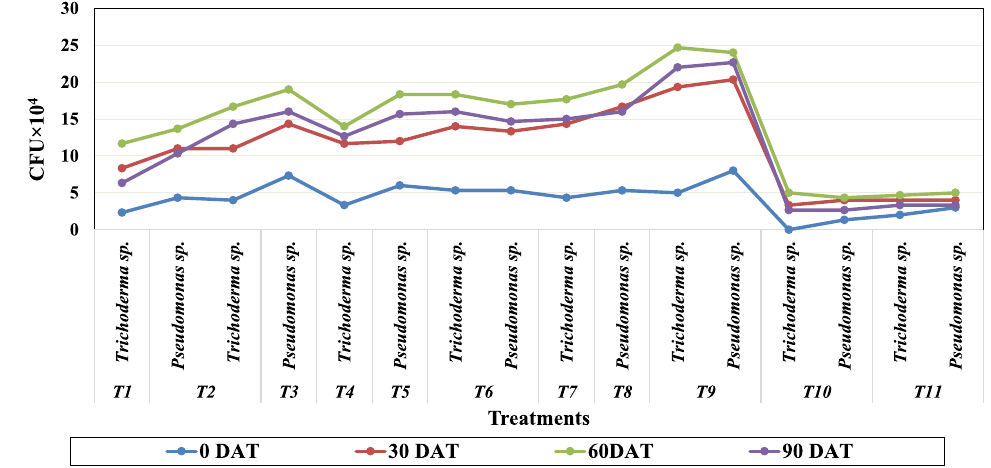
Fig. 4 Rhizoplane Population of Trichoderma spp. and Pseudomonas fluorescens in different combinations of